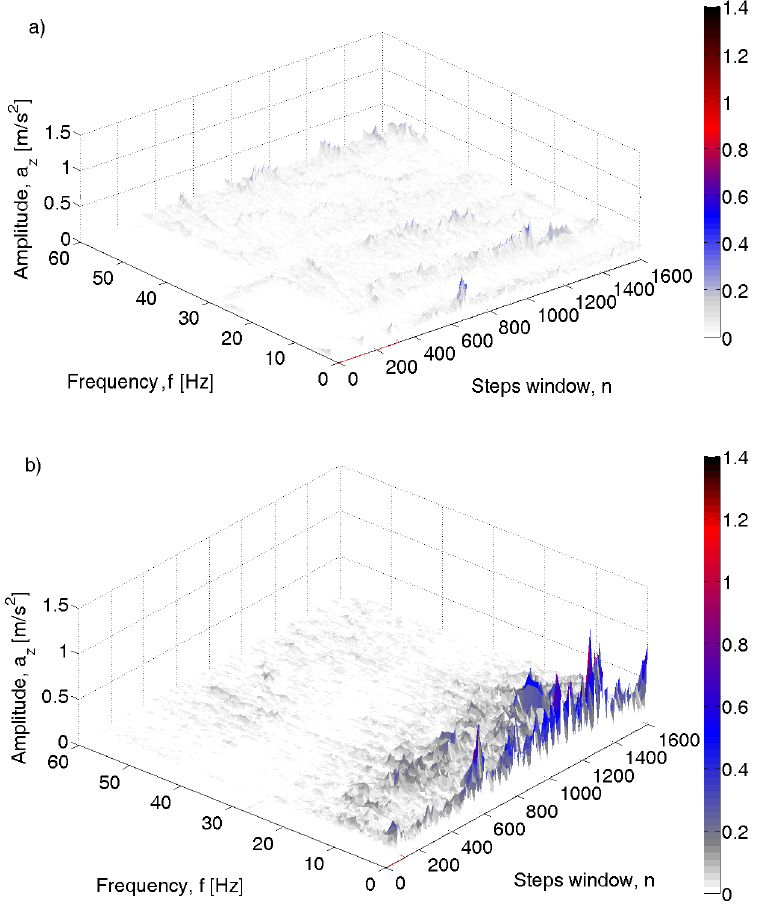
Figure 7. An example of acceleration signal processing ( a ), the effect of using Fourier transform to move from time domain to frequency domain ( b ).